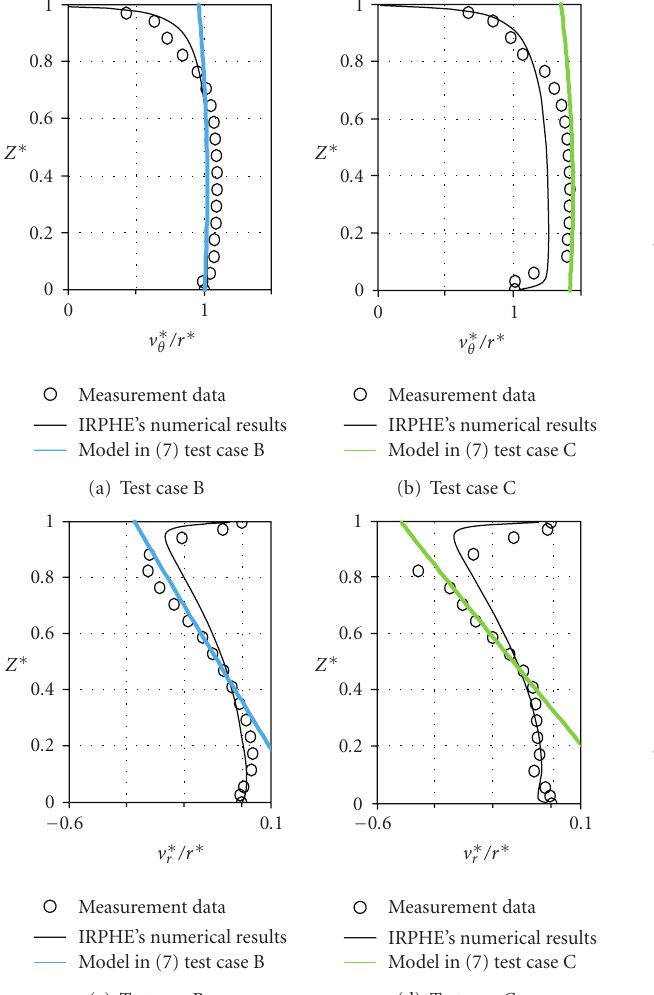
Figure 5: Tangential ((a) and (b)) and radial ((c) and (d)) velocity profiles.